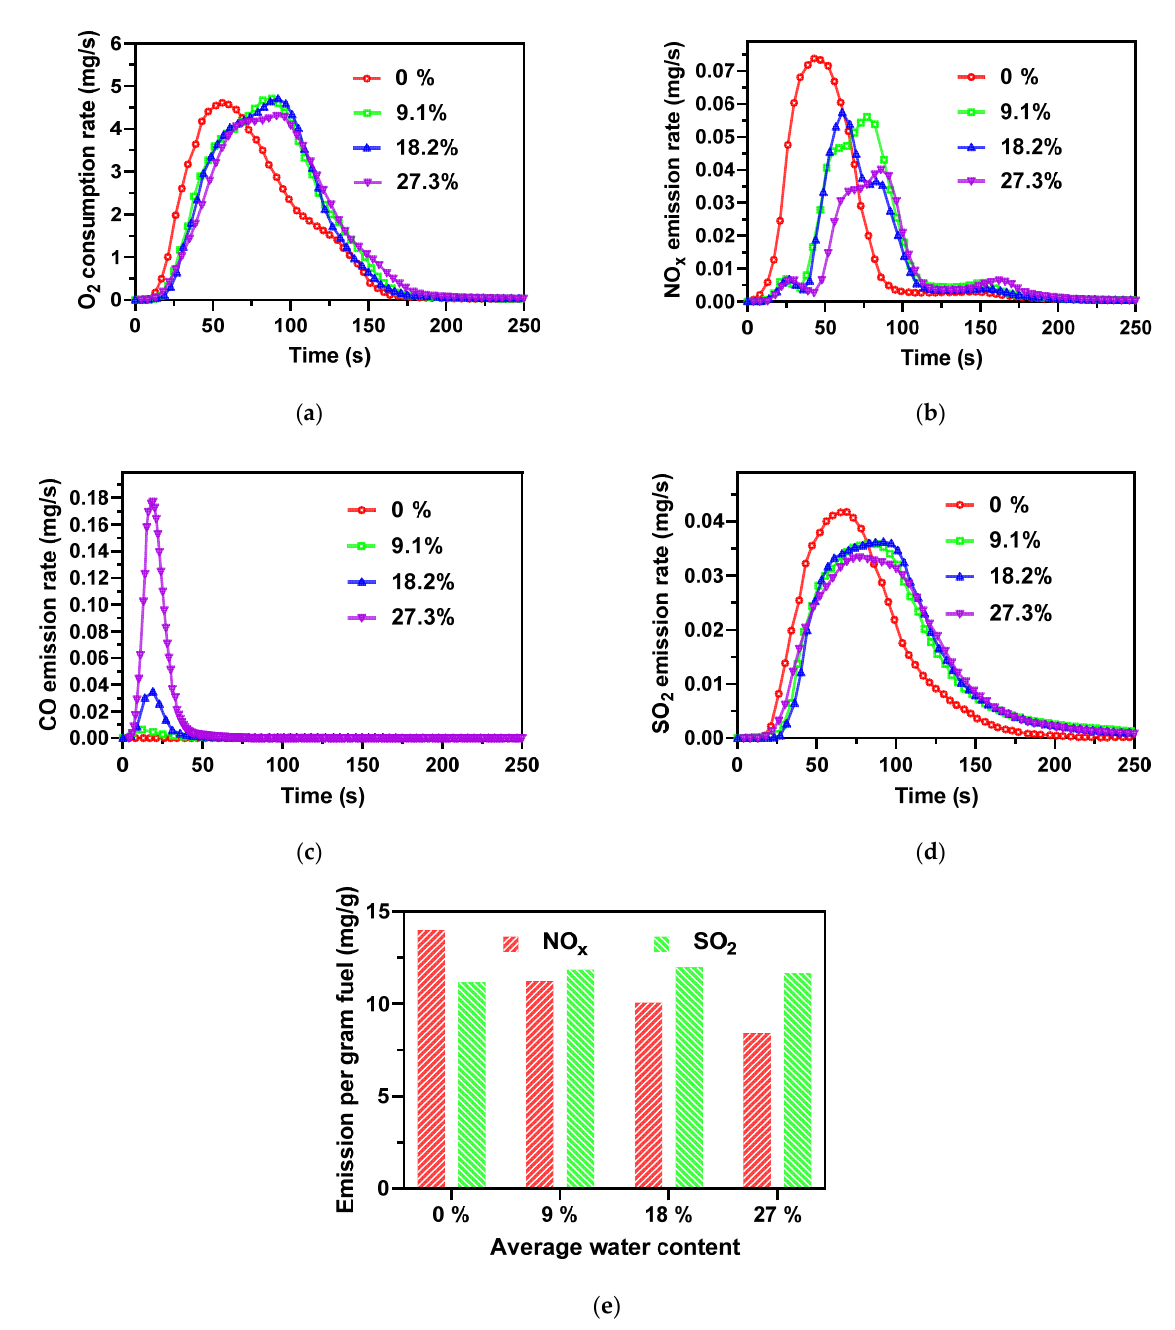
Figure 7. ( a ) O 2 consumption, ( b ) NO x emission, ( c ) CO emission, (d) SO 2 emission as a function of time during combustion of AMR, and ( e ) NO x and SO 2 emissions per gram AMR at different water